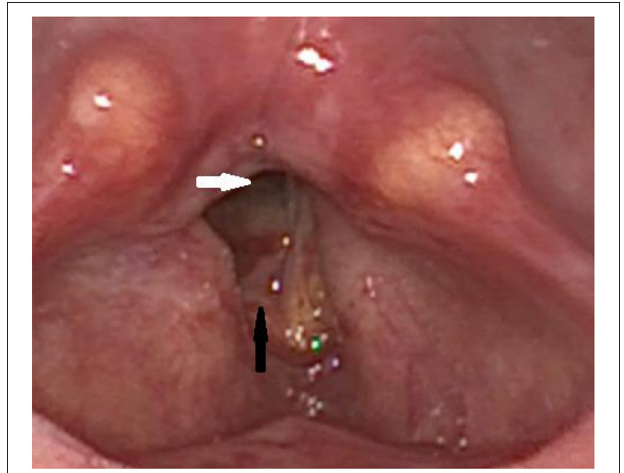
FIGURE 3 | Post-operative finding via laryngoscopy after laser posterior cordectomy: The posterior portion of the glottic gap is open (white arrow), while the anterior portion of the right vocal fold is still swollen postoperatively (black